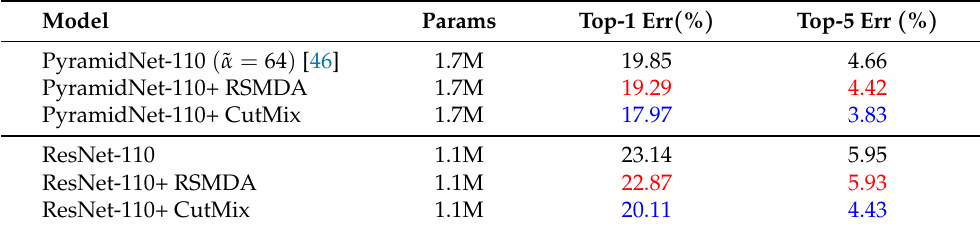
Table 3. Lighter architectures on CIFAR-100. First best and second best performances are highlighted in blue and red color,